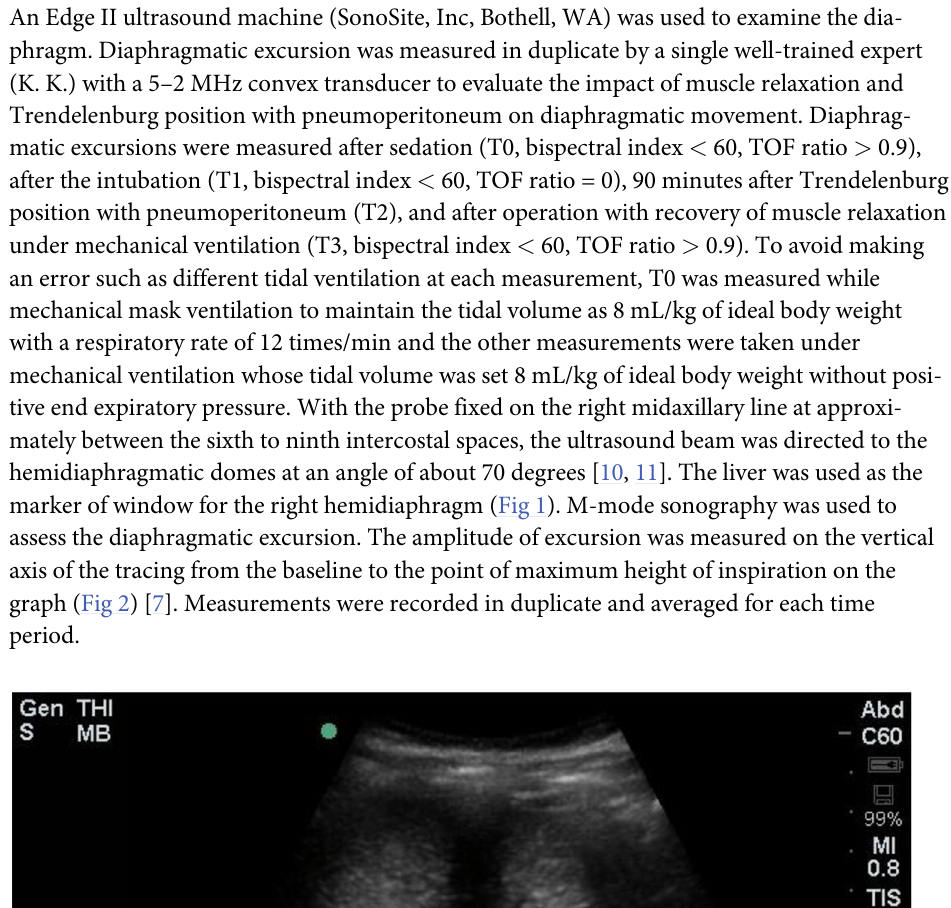
PLOS ONE | https://doi.org/10.1371/journal.pone.0207841 November29,